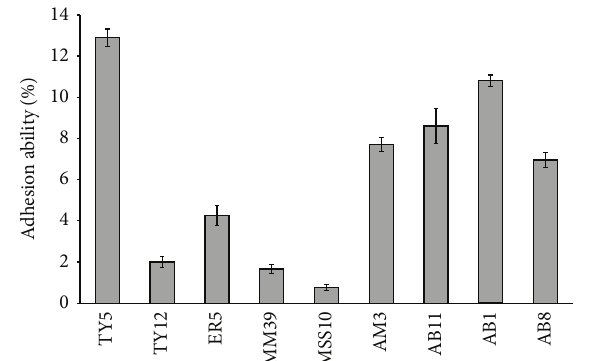
Figure 1: Adhesion ability of LAB isolates to HT-29 cells. The result was represented as mean ± SD of duplicates. The error bar indicates standard deviation.